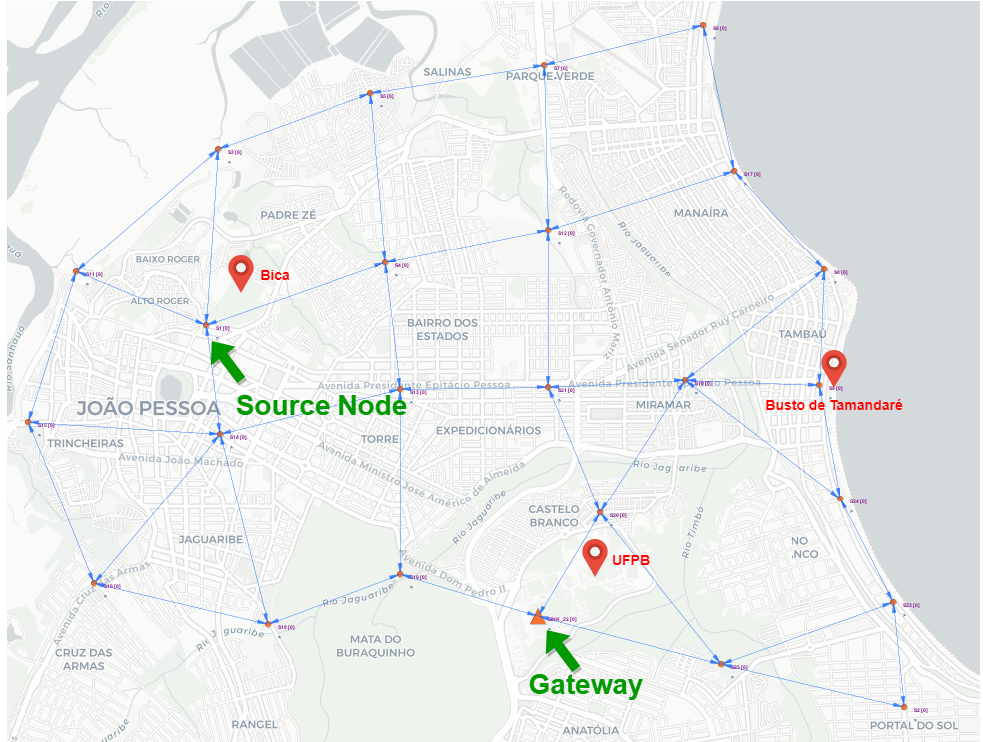
Figure 1. Network topology considered in the